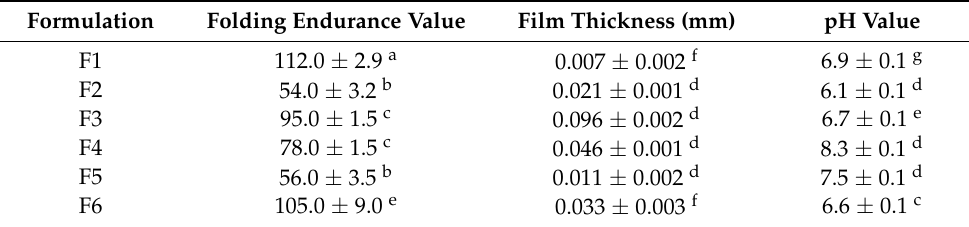
Table 4. Folding endurance value, film thickness and pH of the corresponding film-forming systems (mean ± SD, n =